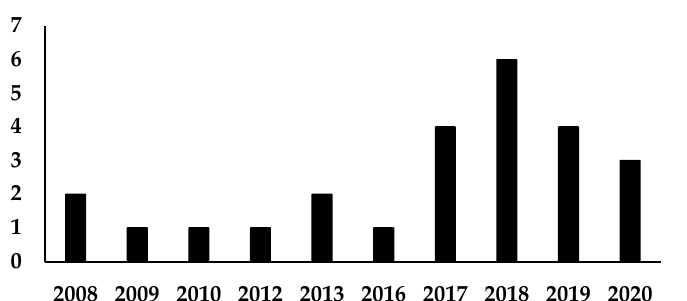
Figure 2. Number of publications related to self-healing materials by Joule effect.